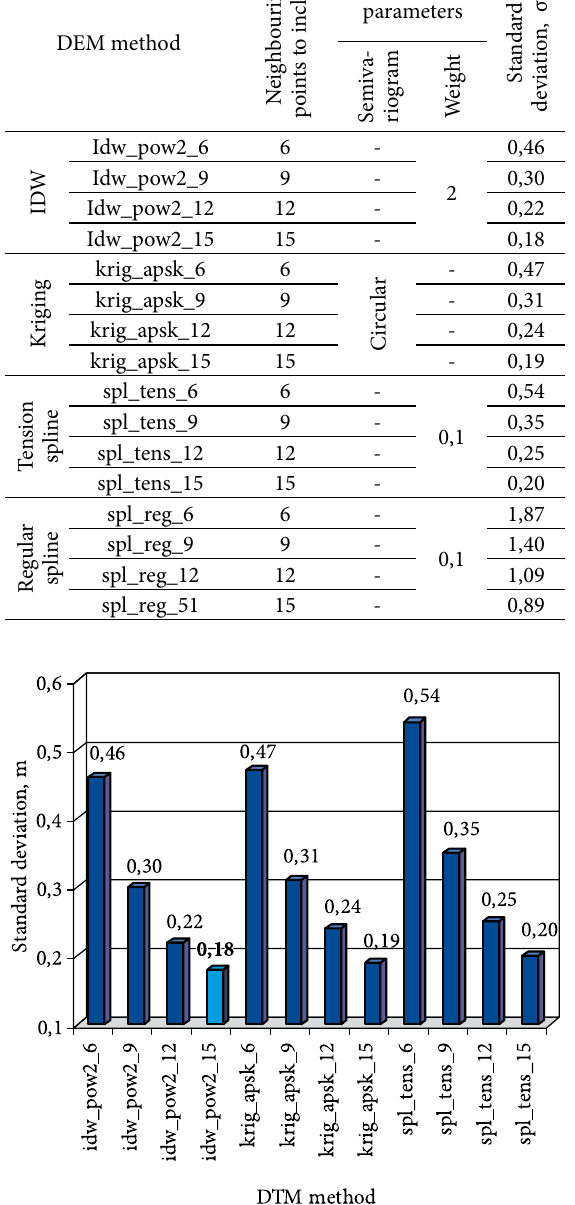
Fig. 2. Accuracy of DEM, using different